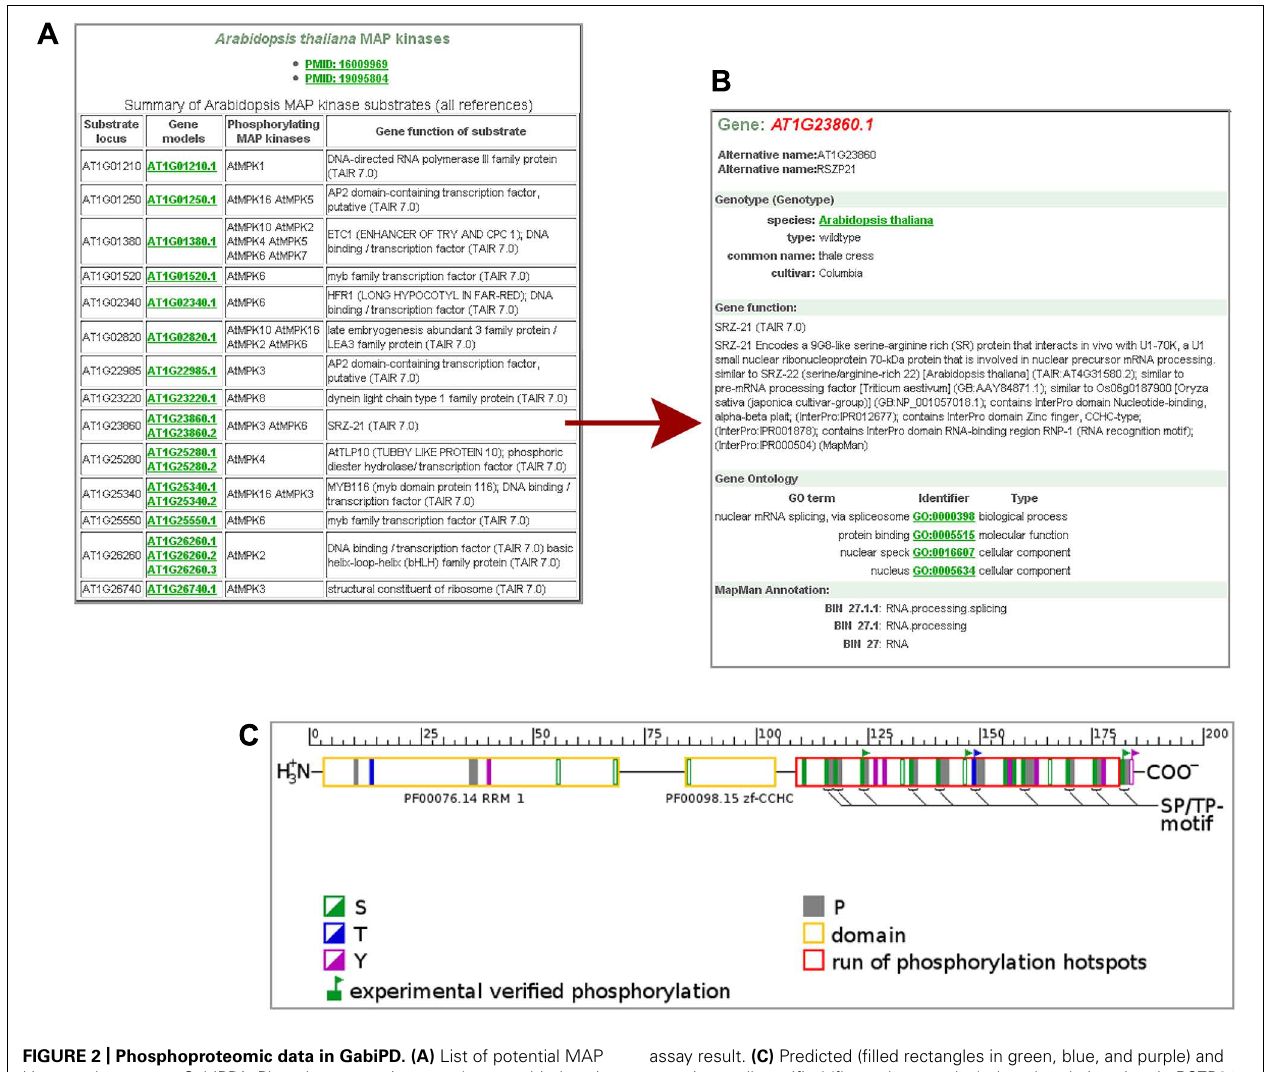
assay result. (C) Predicted (filled rectangles in green, blue, and purple) and experimentally verified (flagged rectangles) phosphorylation sites in RSZP21 according to PhosPhAt (Durek etal., 2010; see external links at the Gene GreenCard).The red long box at the C-terminus of the RSZP21 represents a hot spot of phosphorylation predicted recently (Riaño-Pachón etal., 2010). The yellow boxes display conserved protein